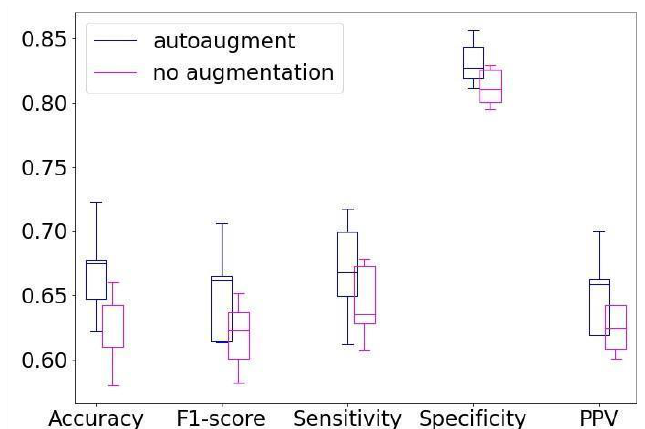
Figure 4. Cross-validation metrics for models trained with and without automated augmentation. The lower bar from the boxes above represents the minimum value, the lower bar of the box the first quartile, the bar in the middle the median, the upper box bar the third quartile, and the upper bar the maximum value. Models trained with augmentations performed significantly better than the model trained with no augmentations ( p <